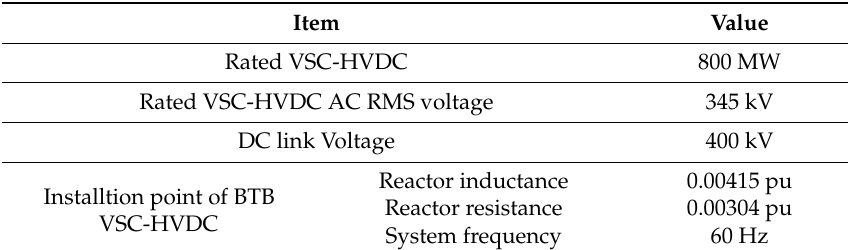
Figure 7. Installation site of the BTB VSC-HVDC system in Seoul. Table 1. Parameters for the BTB VSC-HVDC system and AC